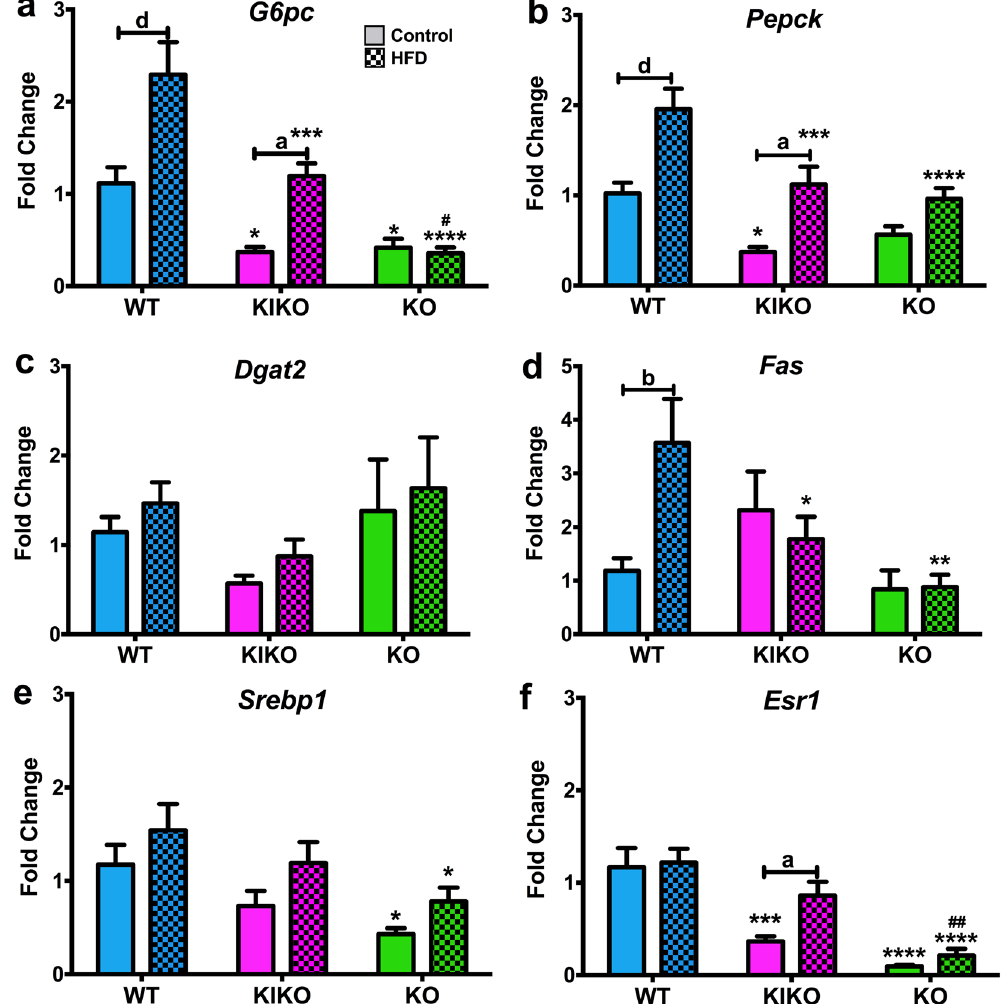
Figure 7. Liver gene expression in all genotypes after 20 weeks of adult chow diet. ( a ) G6pc ; ( b ) Pepck ; ( c ) Dgat2 ; ( d ) Fas ; ( e ) Srebp1 ; and ( f ) Esr1 (ER α ) expression normalized to WT from Control-fed dams. Data were analyzed by a two-way ANOVA with post-hoc Newman-Keuls test within each genotype. See Fig. 1 for information on treatment categories, sample sizes, and statistical comparisons ( a/ * /# = P < 0.05; b/ ** /## = P < 0.01; c/ *** /### = P < 0.001; d/ **** /#### = P <